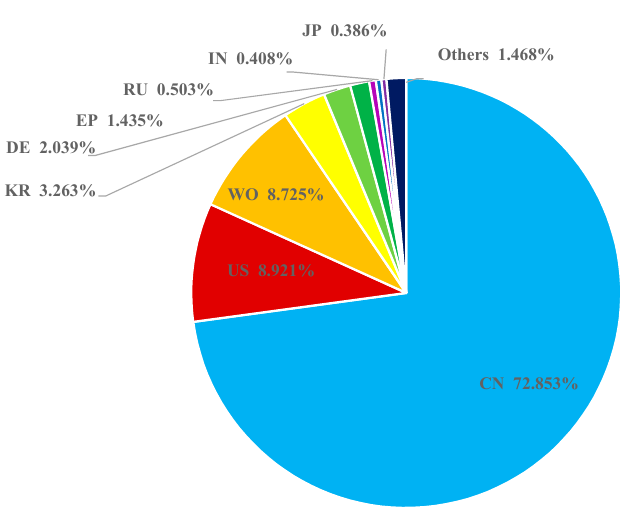
Figure 11. Distribution of 3D printing patents by countries/regions.